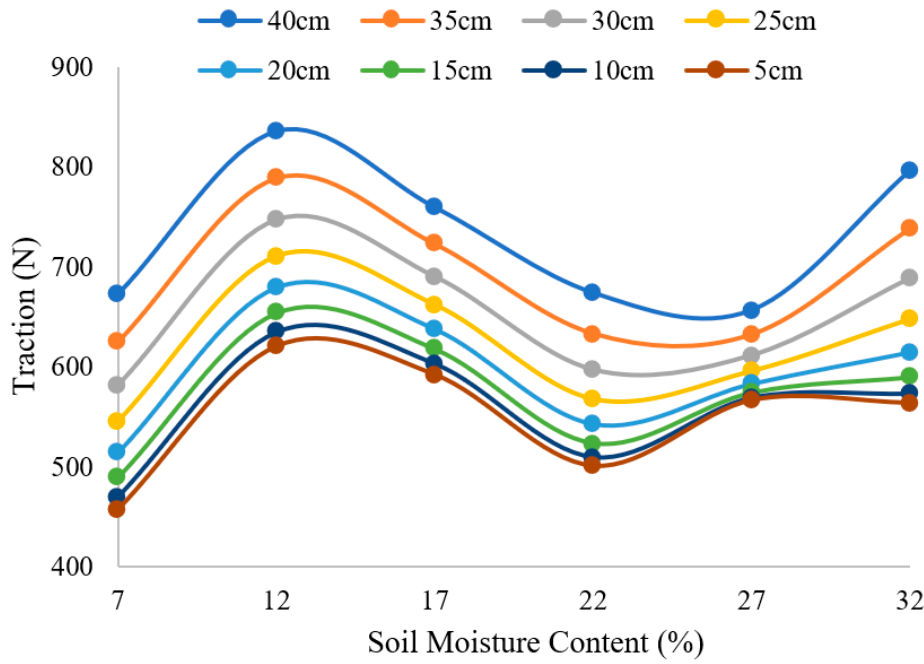
Figure 21. The traction at different grouser heights with different moisture contents.